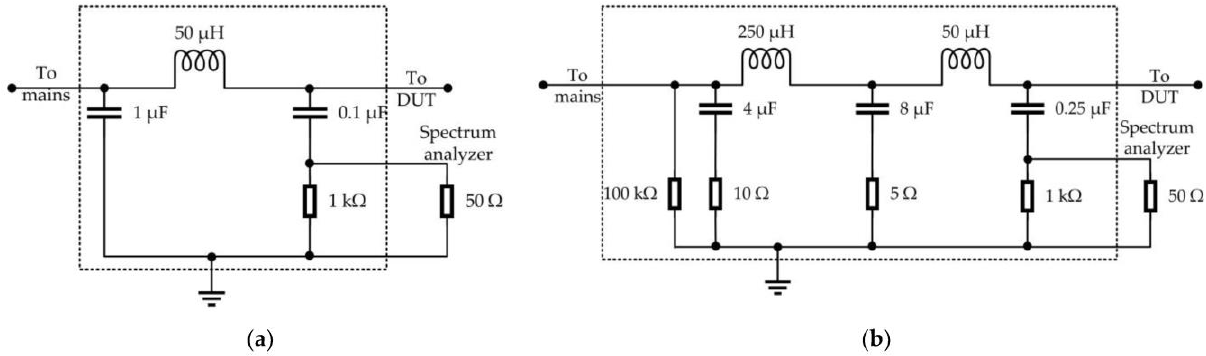
Figure 8. Schematics of the two LISNs considered in this work: ( a ) CISPR22 and ( b ) CISPR16-1-2.